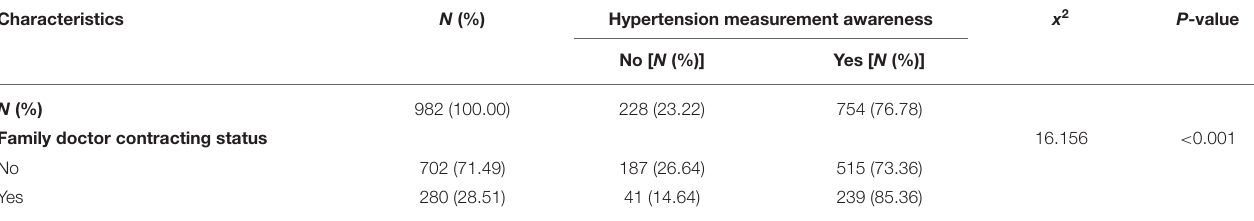
TABLE 2 | The association between family doctor contracting status and blood pressure measurement awareness among hypertension patients in rural Shandong, China.